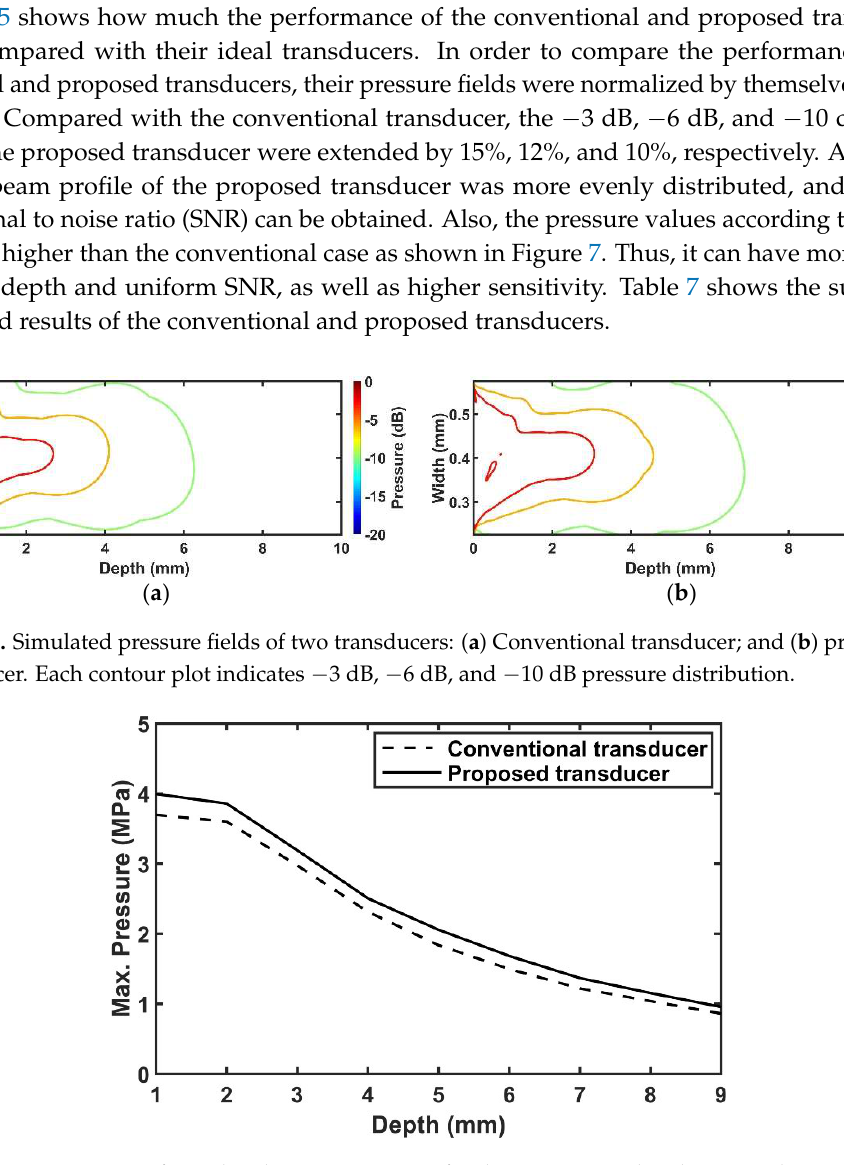
Figure 7. Comparison of simulated pressure pattern for the conventional and proposed transducers. Table 7. Penetration depth calculation based on pressure field simulation results of the conventional and proposed